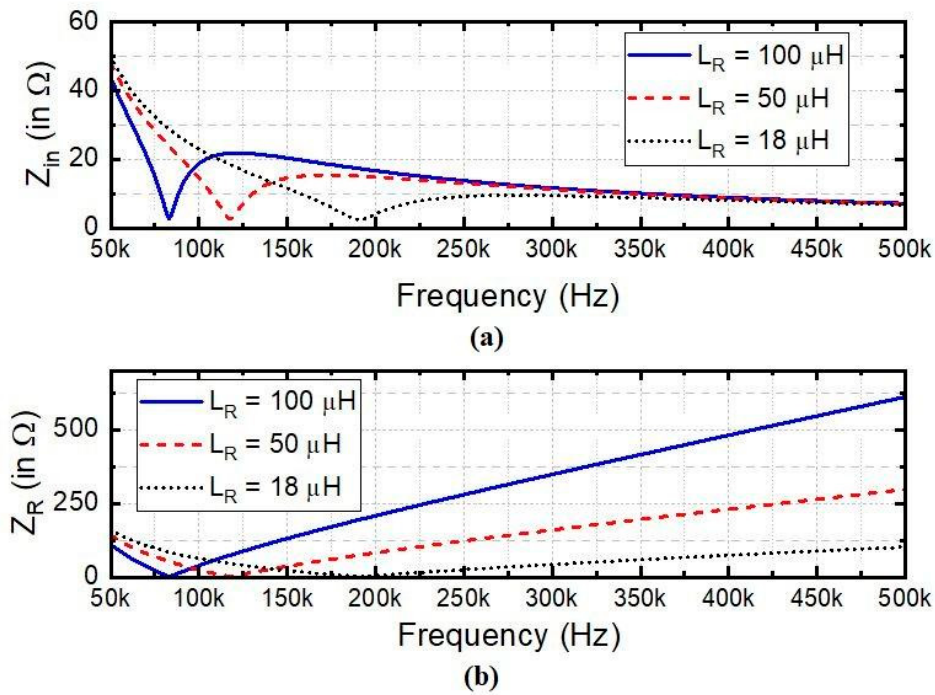
Figure 5. Impedance variation w.r.t frequency for different resonant inductance. The theoretical results were compared with the simulation using an impedance an- alyzer from the Simulink. It is connected across the switch, and the input impedance is measured for all cases, i.e., L r = 18 µ H/50 µ H/100 µ H presented in Figure 6. Comparing Figures 5 and 6, the input impedance graph generated from Simulink closely matches the theoretical results. The optimal resonant point from the simulation matches the theoretical equations. It is important to mention that simulations are performed considering high secondary inductance ( L s = 1 mH), which minimizes the multi-resonant points. The input impedance and resonant network impedance drop significantly at the resonant frequency for each case. Additionally, the variation of phase angle with respect to the frequency shows whether input impedance is inductive or capacitive. The impedance increases w.r.t frequency when the phase angle is positive and decreases when the phase angle is negative; this leads to the circuit behavior being capacitive at a higher frequency. The impedance spike adjacent to the resonant frequency in Figure 6 is due to the diode and components at the receiving section.